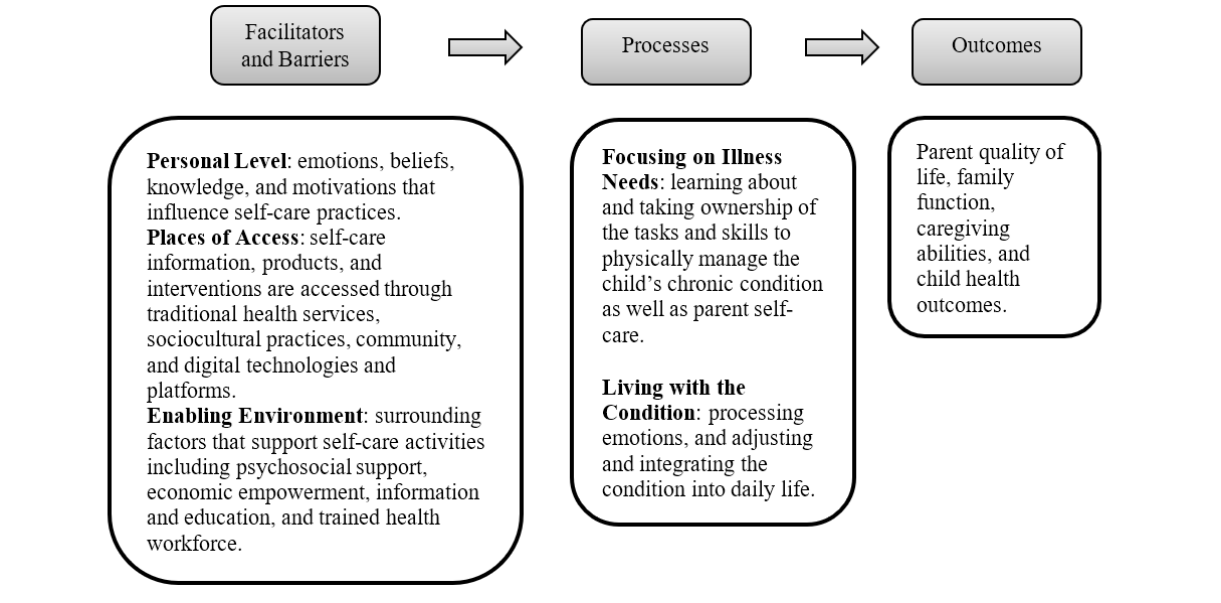
Figure 1. Conceptual framework for self-care among parents caring for children with chronic conditions.